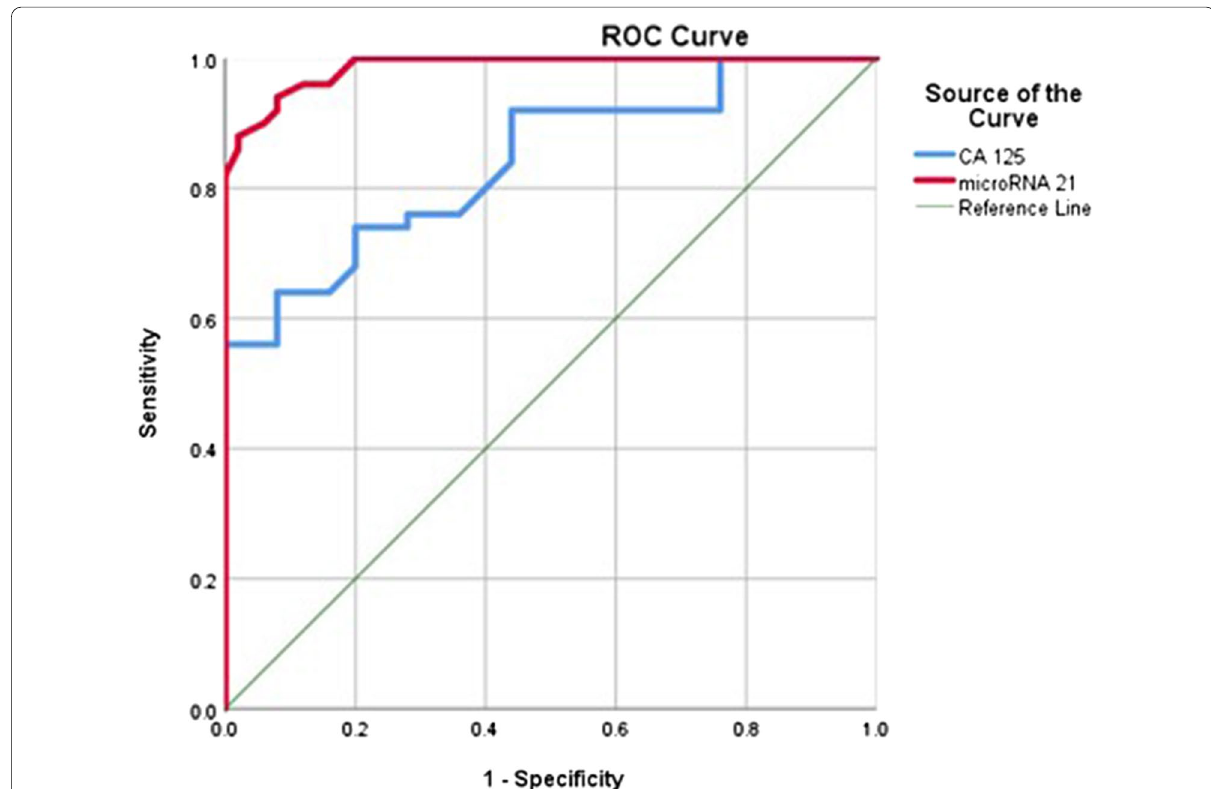
Fig. 1 ROC curve for miR-21 as a diagnostic marker of ovarian cancer